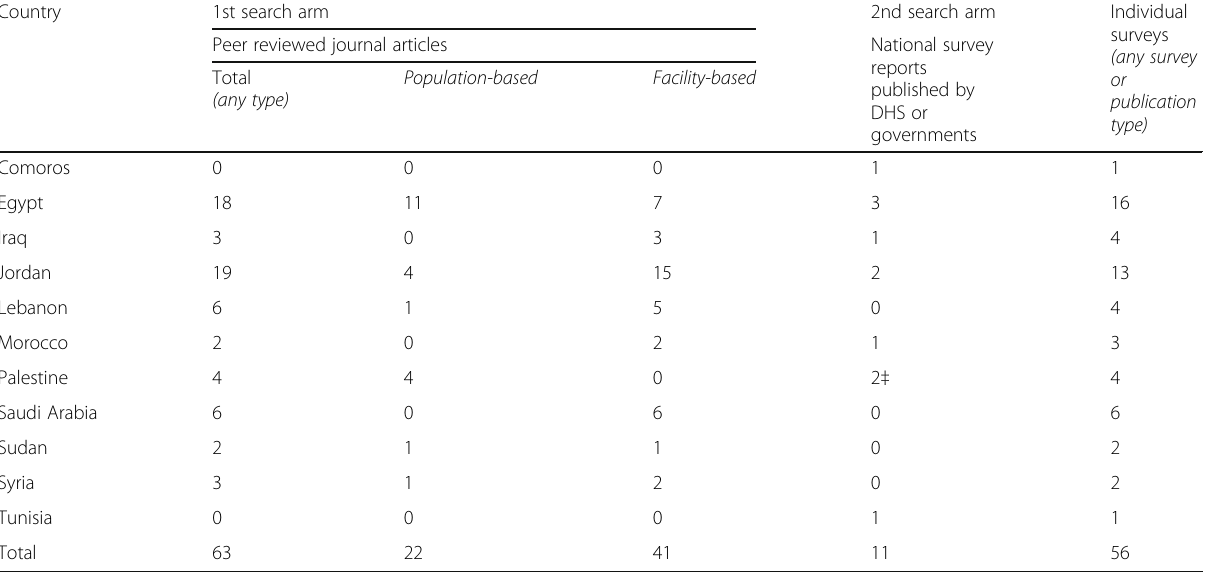
Table 1 Number of eligible IPV sources and surveys published 2000 – 2016, by country and type Country 1st search